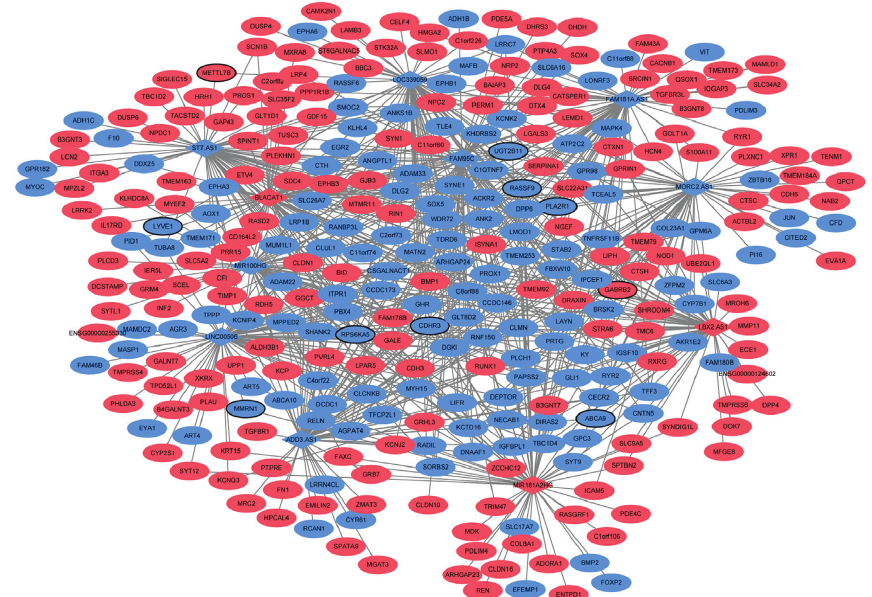
Figure 4: The interaction network of diagnostic lncRNA-co-expressed mRNA in PTC based on the cor.test function in R . Rhombus and ellipse represent diagnostic lncRNA and co-expressed mRNA, respectively; red and blue colors represent the upregulation and down- regulation, respectively; the black border represents the top 10 upregulated and top 10 downregulated mRNA.